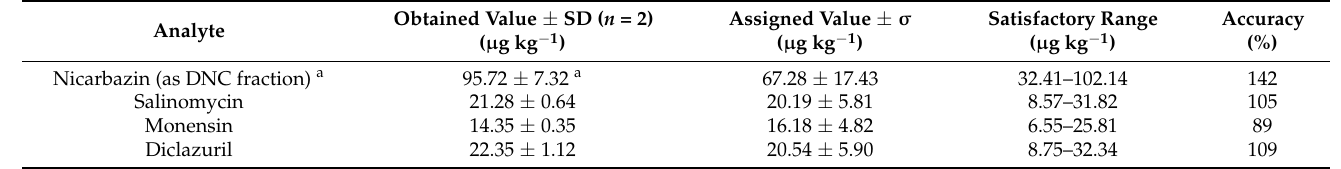
Table 6. Analysis of CRM M1406/CM turkey muscle (Test